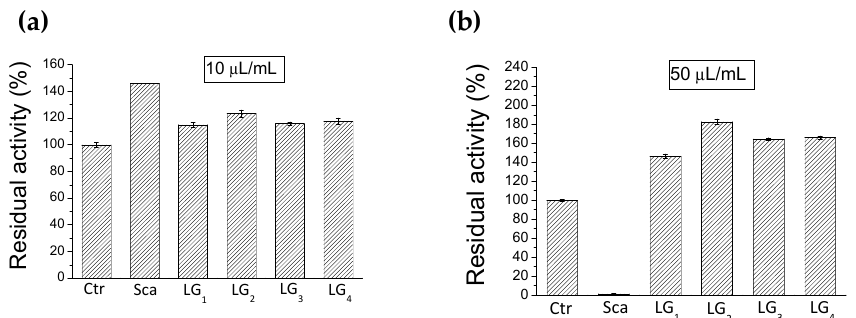
Figure 4. Residual activity of PTP1B enzyme (in vitro %); schaftoside standard (Sca) and Lisosan ® G extracts (LG 1 –LG 4 ) were tested at two concentrations: ( a ) 10 µ L/mL corresponding to 2.7 µ M for schaftoside and 1.25 mg/mL for Lisosan ® G extracts; ( b ) 50 µ L/mL corresponding to 13.5 µ M for schaftoside and 6.25 mg/mL for Lisosan ® G extracts. Ctrl for control (see experimental